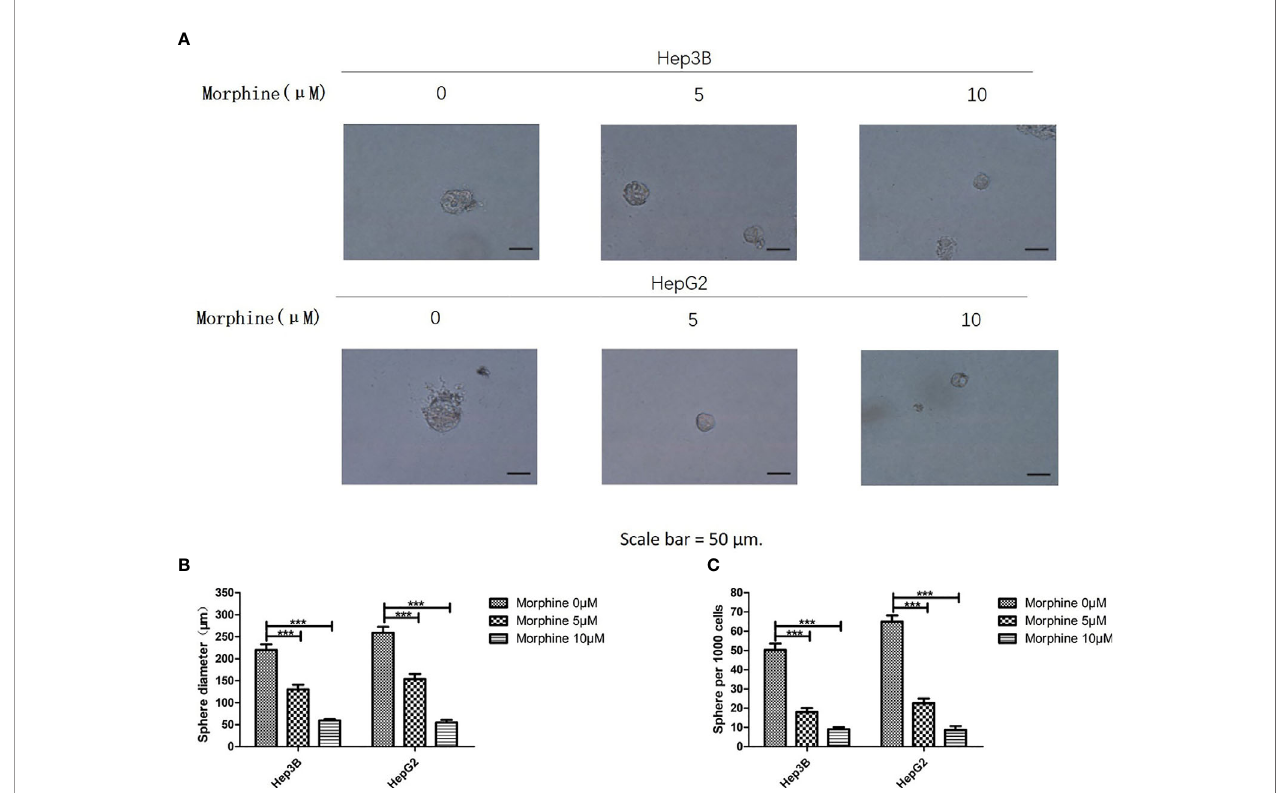
FIGURE 4 | Morphine inhibits the sphere formation ability of Hep3B/HepG2 cells. (A) Representative pictures of spheres formed by Hep3B/HepG2 cells after treating with morphine (0, 5, 10 m M) for 24h, respectively (Scale bars, 50 m m). (B, C) Bar diagrams showed the diameter and number of spheres (spheres > 50 m m). Data are expressed as mean ± SE; n=3. *** P <